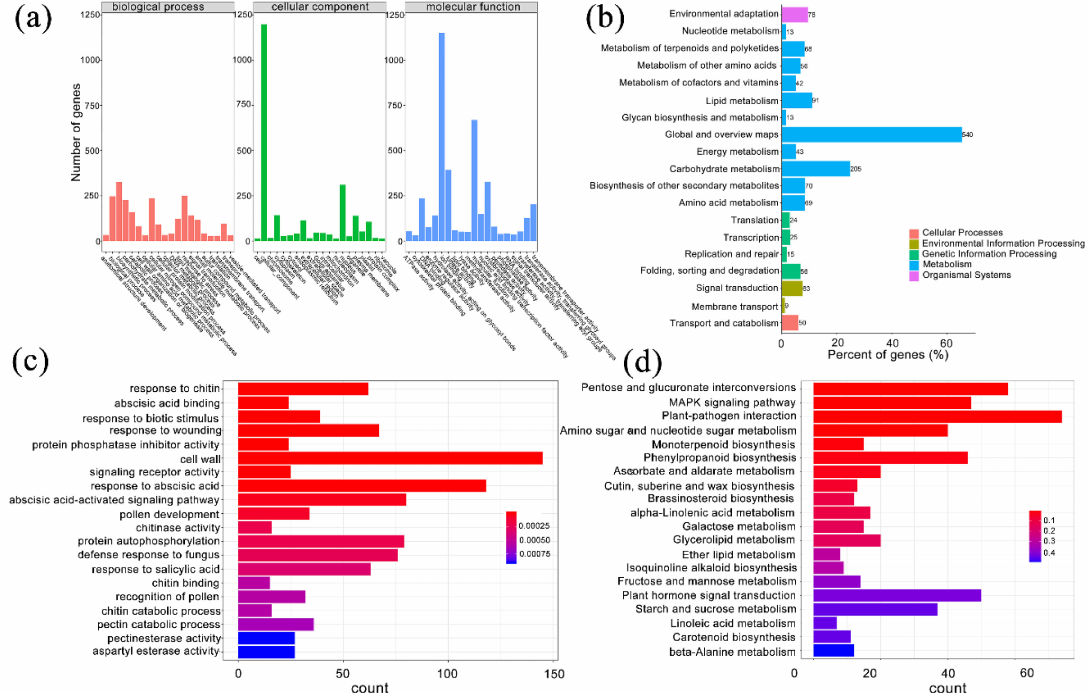
Figure 3. Functional classification and enrichment analysis of differentially expressed genes (DEGs) in P. mume . ( a ) Gene ontology (GO) classification of DEGs. The horizontal axis is the GO slim classification, and the vertical axis is the number of genes. ( b ) KEGG pathway classification of DEGs. The vertical axis is the name of the KEGG metabolic pathway, the horizontal axis is the ratio of the number of genes annotated to the pathway to the total number of annotated genes, and the value in the figure is the number of genes annotated to the pathway. ( c ) GO enrichment analysis of DEGs. The horizontal axis is the number of differentially expressed genes, and the vertical axis is the functional classification of GO. The color represents the q -value, and the smaller the q -value, the more significant it is. ( d ) KEGG enrichment analysis of DEGs. The horizontal axis is the number of differentially expressed genes, the vertical axis is KEGG Pathway, the color represents q -value, and the smaller the q -value, the more significant the enrichment result